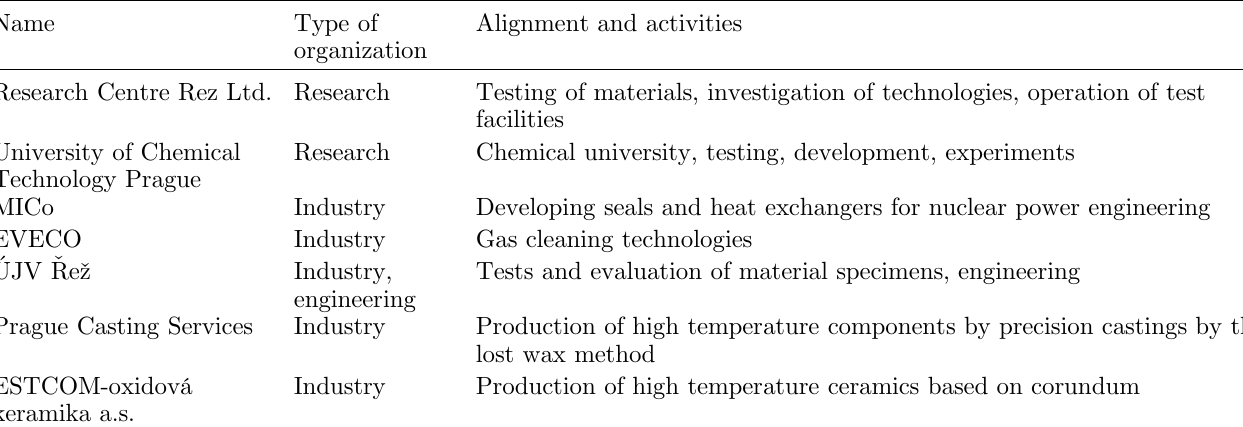
Table 1. List of organizations involved in Czech HTR program.